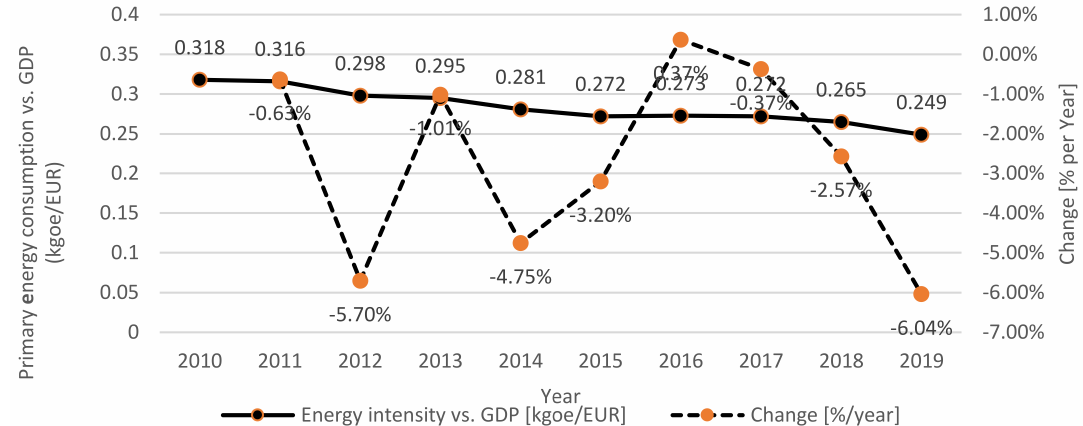
Figure A2. Primary energy consumption vs. GDP (kgoe/EUR) in Poland in 2010–2019. Source: own elaboration based on Statistics Poland [27].